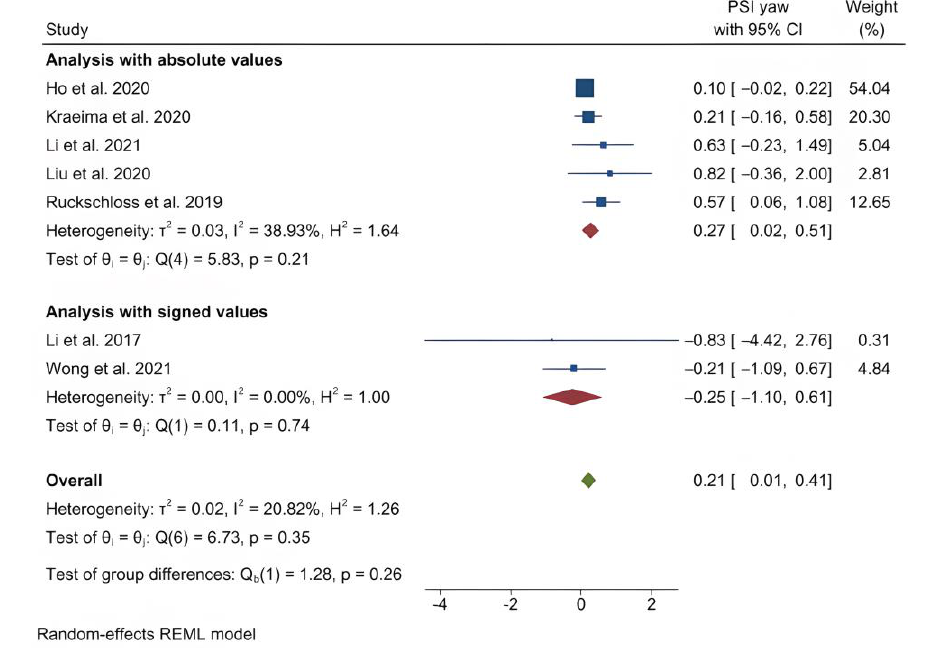
Figure 8. Forest plot showing mean yaw deviation.